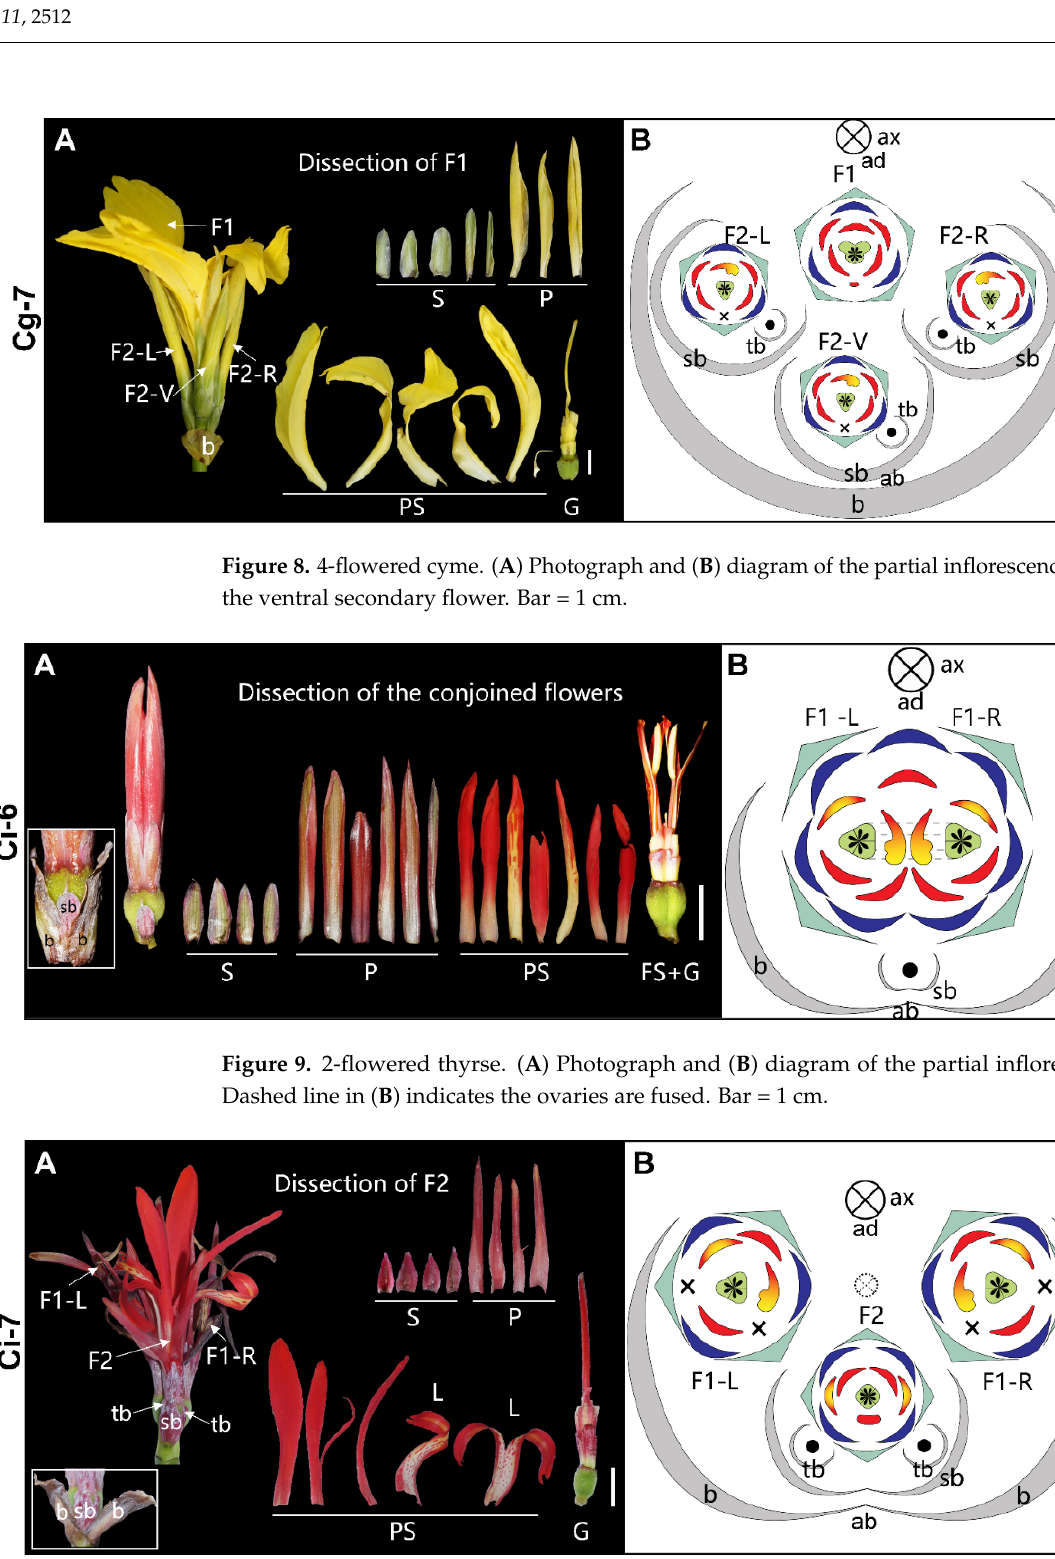
Figure 10. 3-flowered thyrse. ( A ) Photograph and ( B ) diagram of the partial inflorescence of Ci-7. Dashed circle with the × in ( B ) indicates the early aborted raceme axis of the truncated thyrse. Bar = 1 cm.